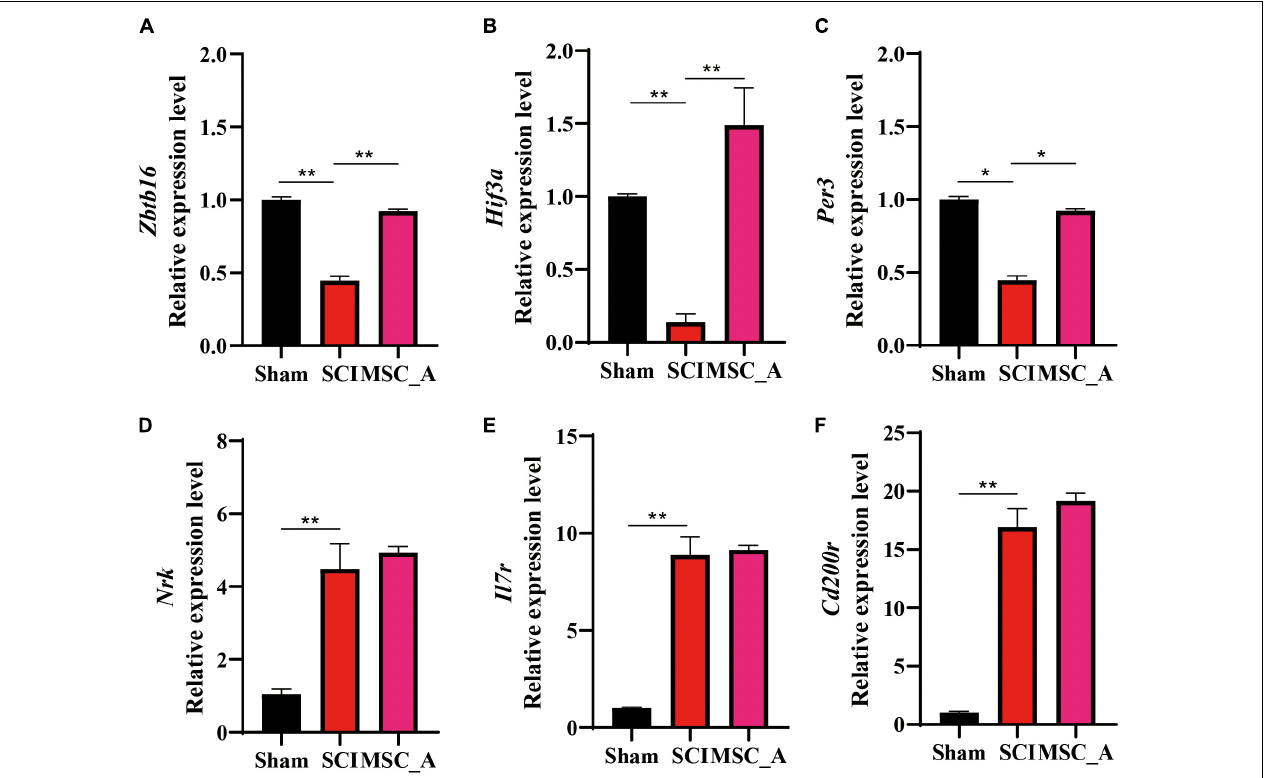
FIGURE 8 | Validation results for Zbtb16 , Hif3- α , Per3 , Il7r , Cd200r4 , and Nrk mRNA by q-PCR. (A–F) Validation results for Zbtb16 , Hif3- α , Per3 , Il7r , Cd200r4 , and Nrk mRNA by q-PCR. All data are presented as the mean ± SEM; n = 3; *p < 0.05; ** p <